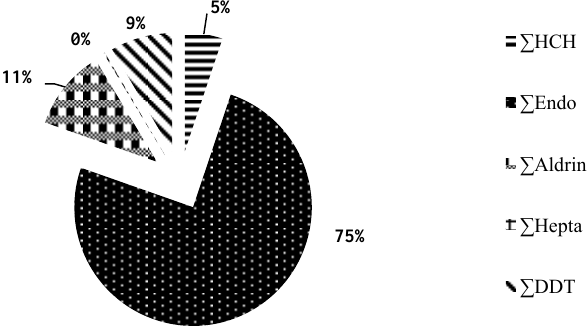
Figure 6. Detection frequency of individual OCPs across UP stretch of Ganga Figure 6: Detection frequency of individual OCPs across UP stretch of Ganga River